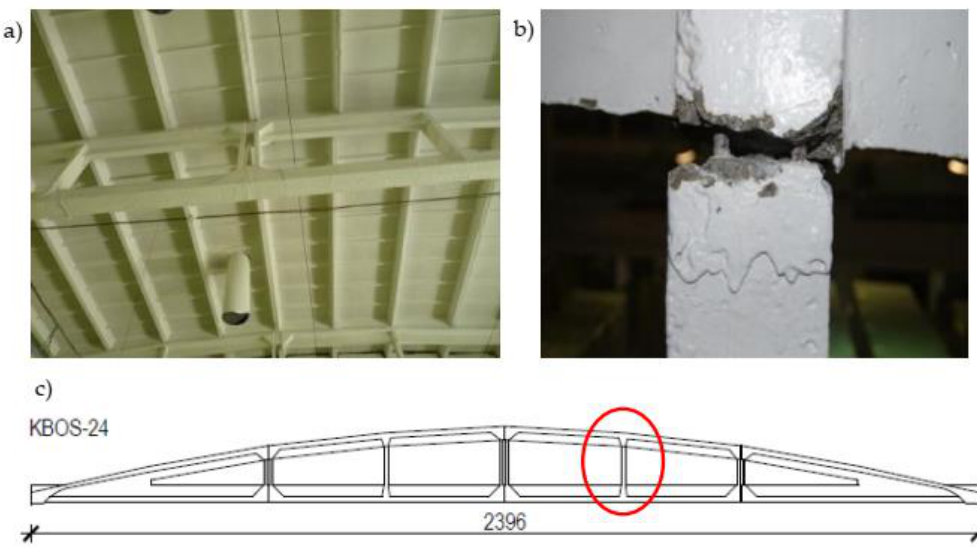
Figure 2. Posttensioned concrete girder KBOS-24: ( a ) View of erected roof construction; ( b ) Damage of the column; ( c ) View (span) of whole girder.